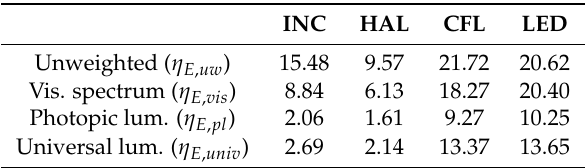
Table 4. Valuable energy efficiencies ( η E , L , v , in %) for each lamp and each weighting function ( f λ ), given by Equation (36). Note that for the incandescent (INC) and halogen (HAL) lamps, the unweighted energy efficiency ( η E , uw ) is underestimated, because the SPD data do not go beyond 899 nm, despite INC and HAL emission beyond 900 nm.